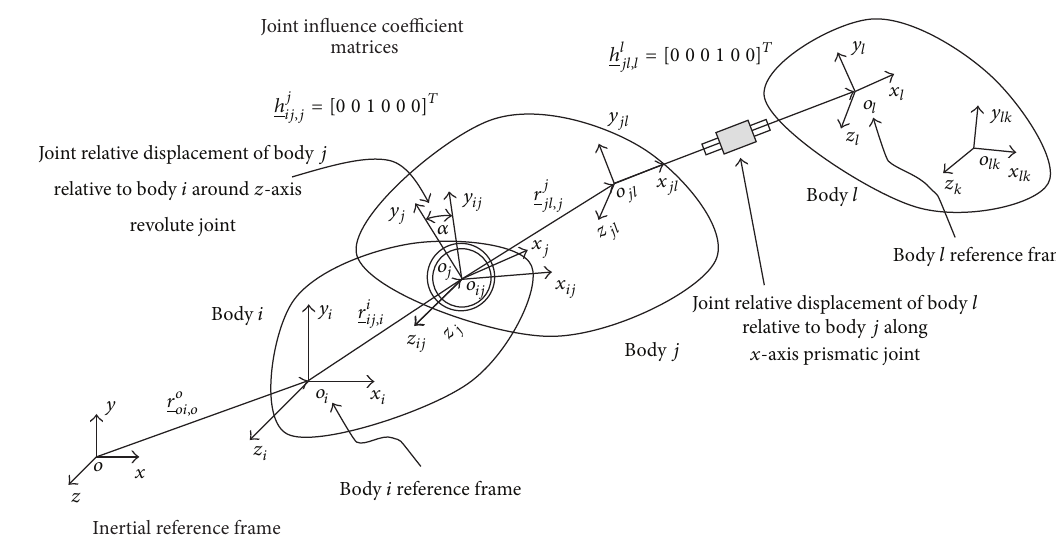
Figure 3: Body kinematics and joint